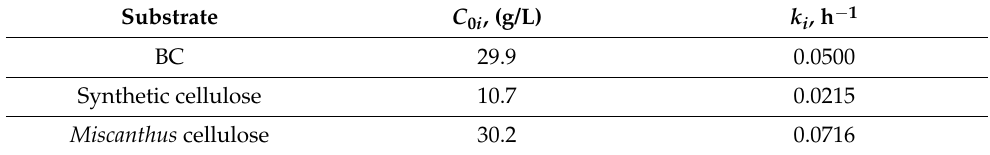
Table 3. Values of the characteristics of the constants of the enzymatic hydrolysis process. Substrate C 0 i , (g/L) k i , h − 1 BC 29.9 0.0500 Synthetic cellulose 10.7 0.0215 Miscanthus cellulose 30.2